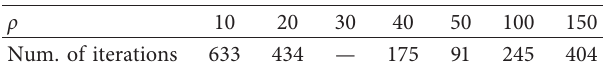
Table 2: Numbers of iterations with different penalty parameter values.